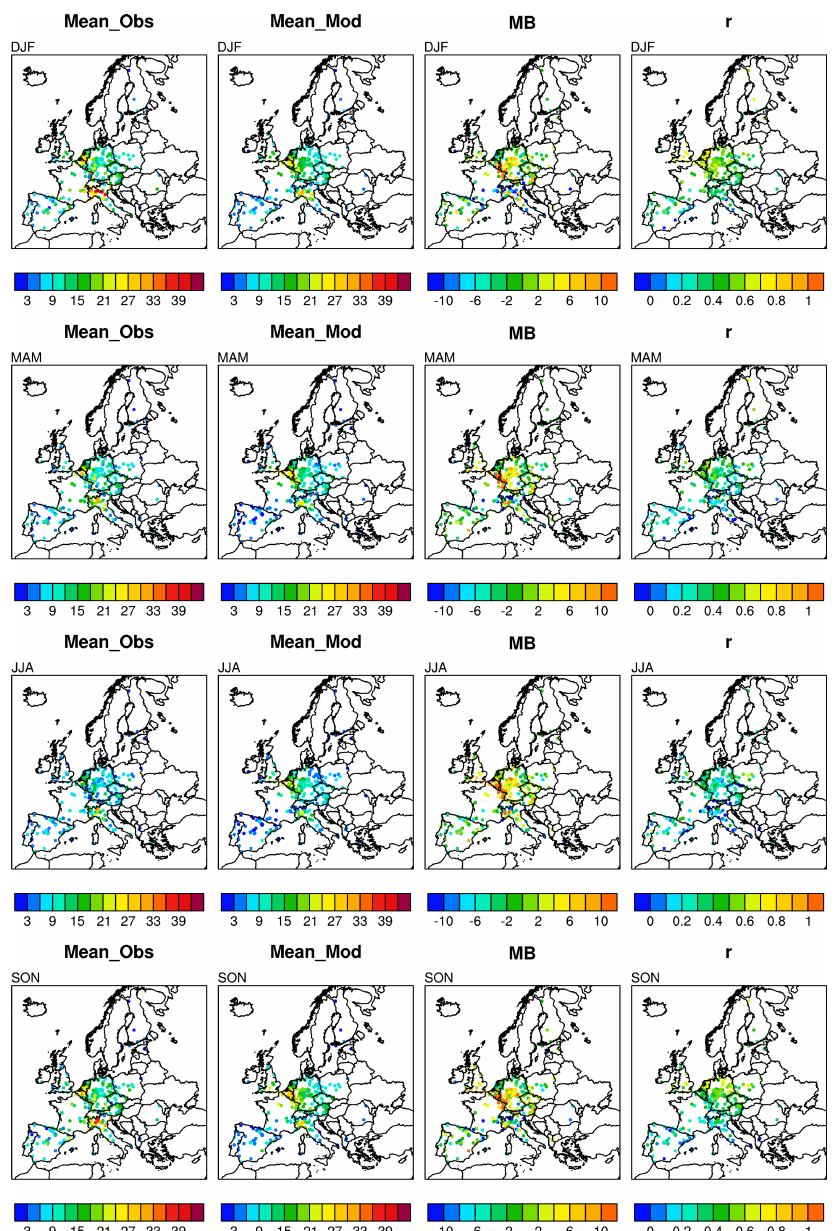
Figure 14. Seasonal average values of surface NO 2 in µgm − 3 from hourly measurements at AirBase (circles) and EMEP (squares) stations, and modeled values from RADM2 for corresponding locations. The MB and temporal correlation coefficient ( r ) for hourly values are also shown at the location of station